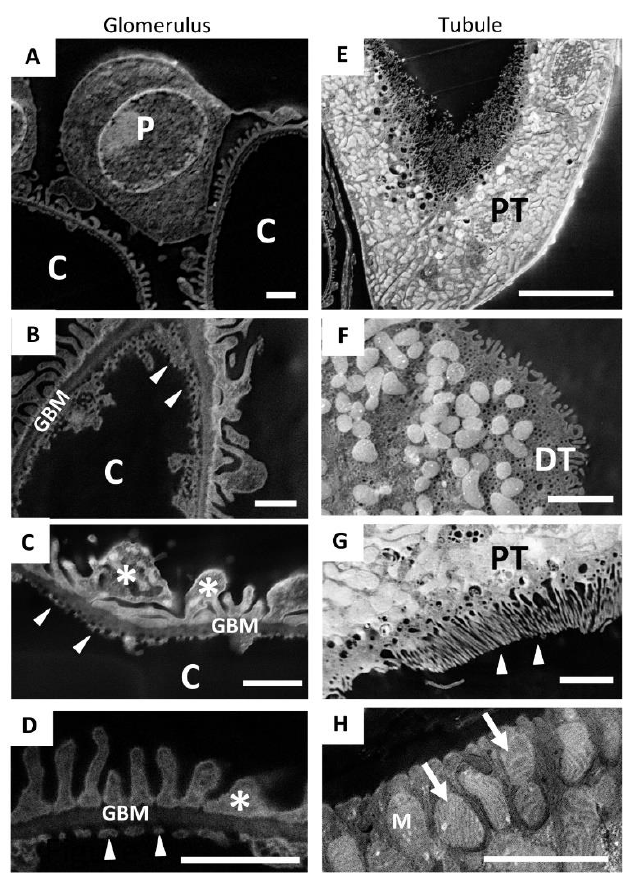
Figure 5. SE–SEM method makes it possible to recognise the fine ultrastructure of the different renal compartments: ( A – D ) representative SE–SEM images of the components of the glomerular filtration barrier, such as ( B – D ) fenestrated endothelium (arrowheads) and ( D ) podocyte foot processes (as- terisks); ( E , H ) SE–SEM images of the tubular compartment; ( F ) a distal tubule and ( E ) a proximal tubule, with ( G ) its luminal brush border (arrowheads); ( H ) the complex organisation of lamellar cristae (arrows) within the mitochondria of tubular cells observed with SE–SEM. Scale bars: 1 µ m for ( A – D ); 10 µ m for ( E ) and 2 µ m for ( F – H ). Abbreviations: P, podocyte; C, capillary lumen; GBM, glomerular basement membrane; PT, proximal tubule; DT, distal tubule; M,